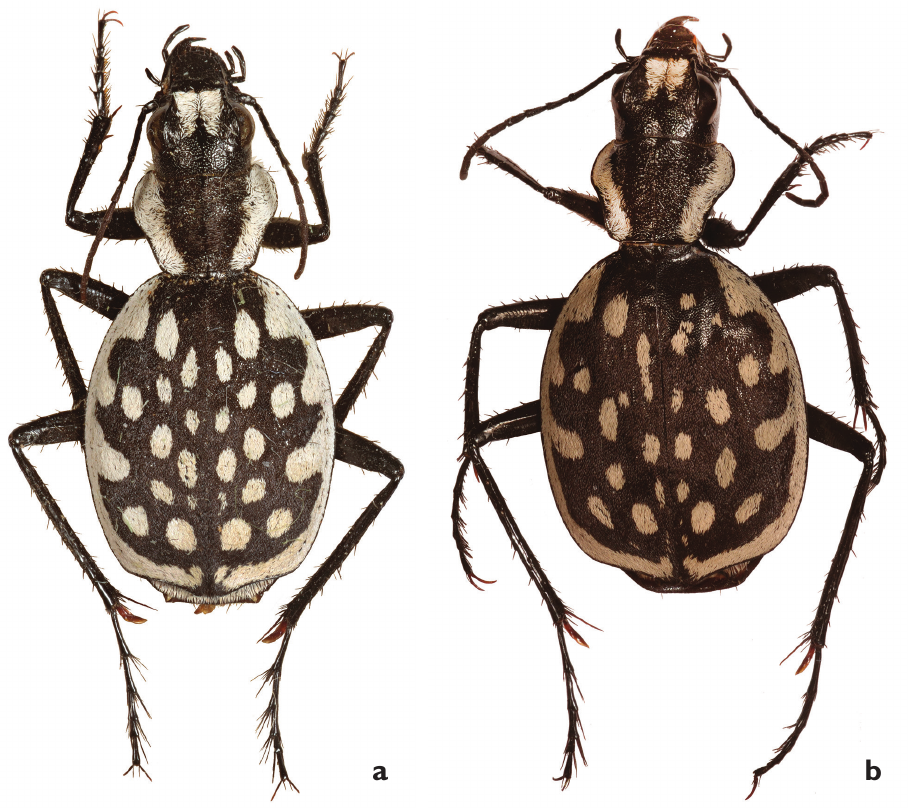
a Figure 25. Dorsal habitus of Graphipterus : a G. piniamitaii sp. n. b G. reymondi.